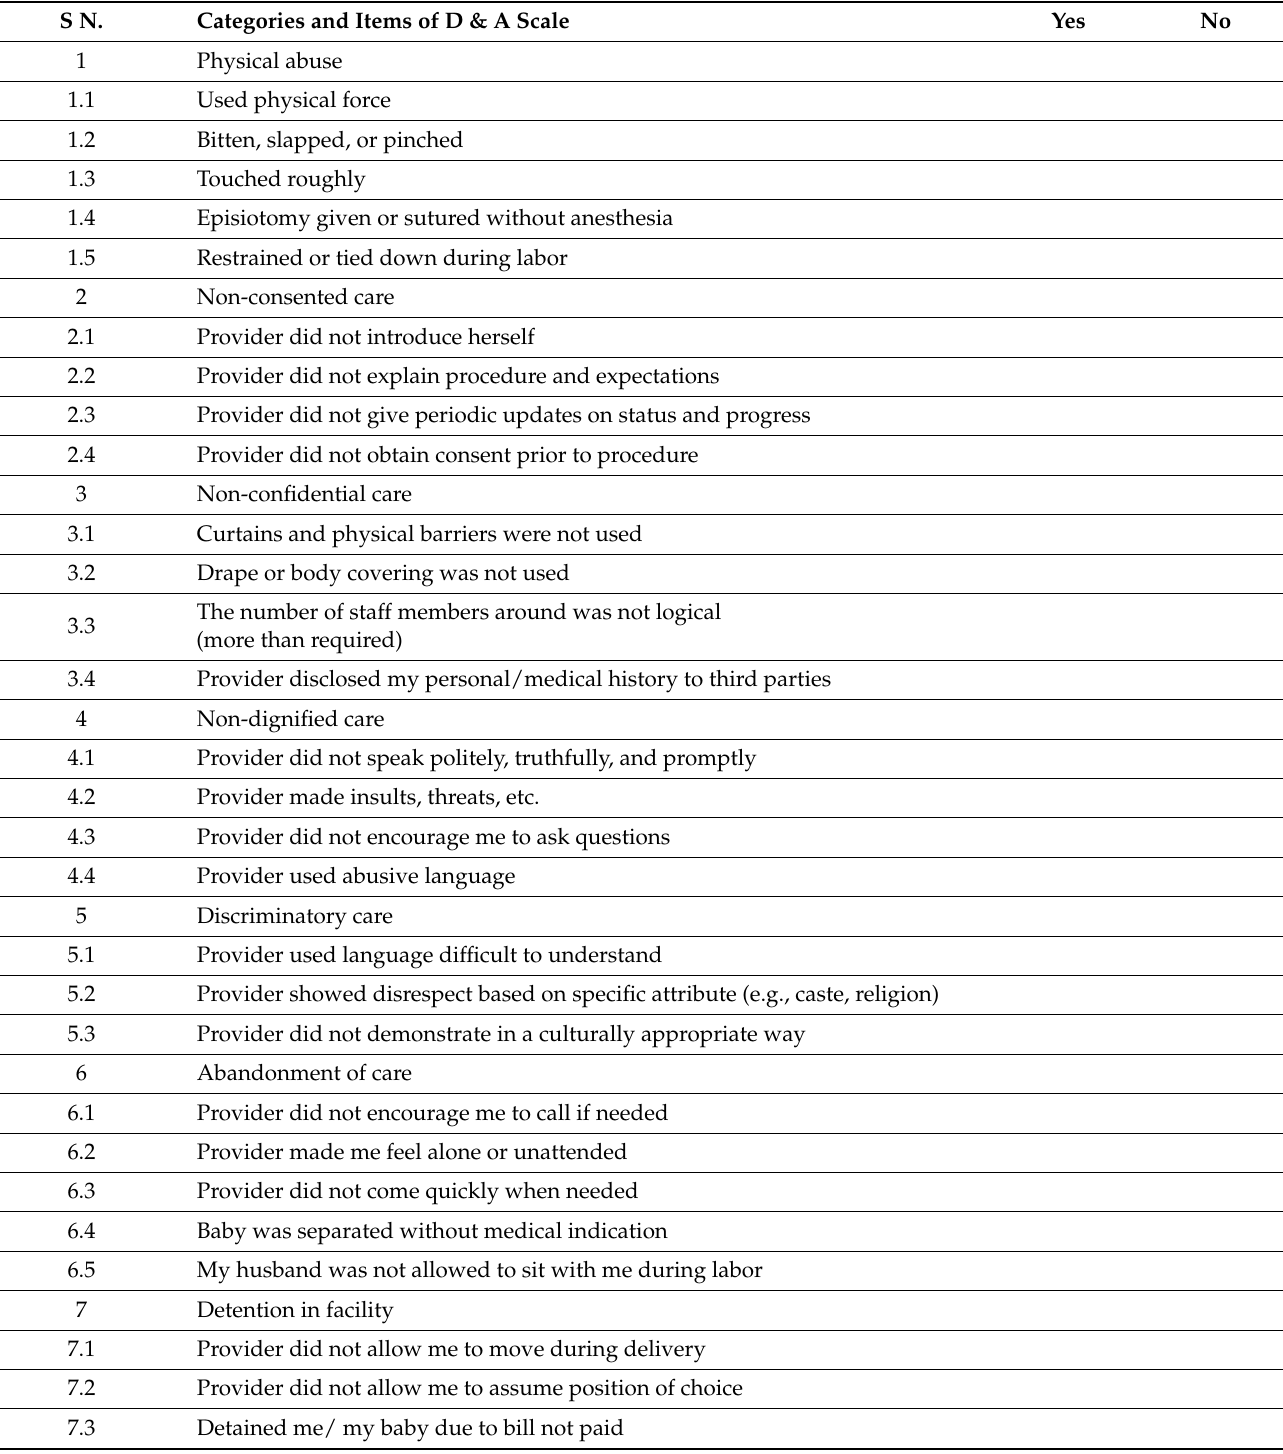
Table 1. Categories and items of disrespect and abuse during